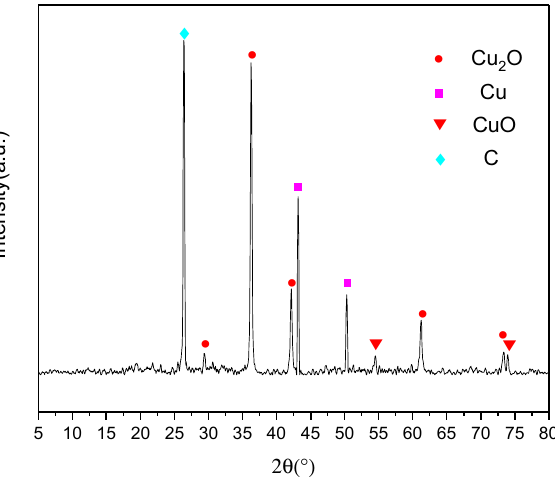
Figure 8. The DSC curves of ( a ) GO and ( b ) CuO–GO.